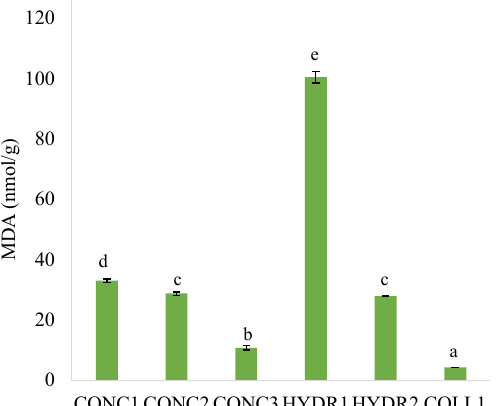
Figure 5. Malondialdehyde (MDA) contents (nmol MDA/g powder “as is”) of commercial fish protein concentrates, hydrolysates, and hydrolyzed collagen. Fish protein concentrates = CONC1–3, fish protein hydrolysates = HYDR1–2, hydrolyzed fish collagen = COLL1. Different letters indicate a statistically significant difference with ANOVA post hoc pair comparison ( p < 0.05).